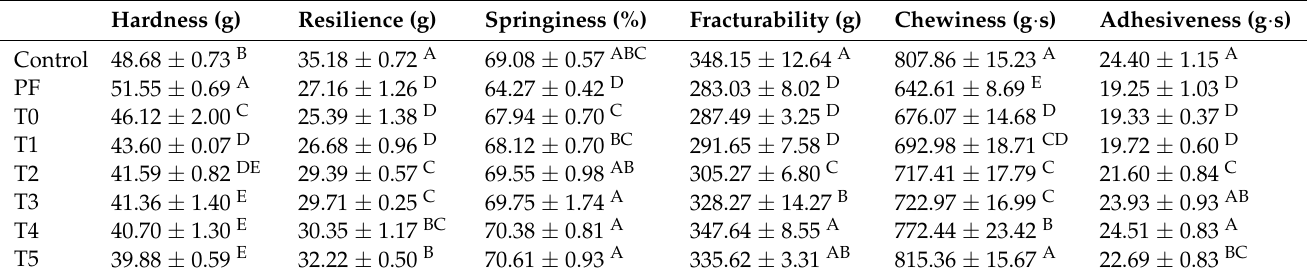
Table 7. Textural properties of phosphate-containing frankfurters or phosphate-free frankfurters added with the combination of L-Arg and